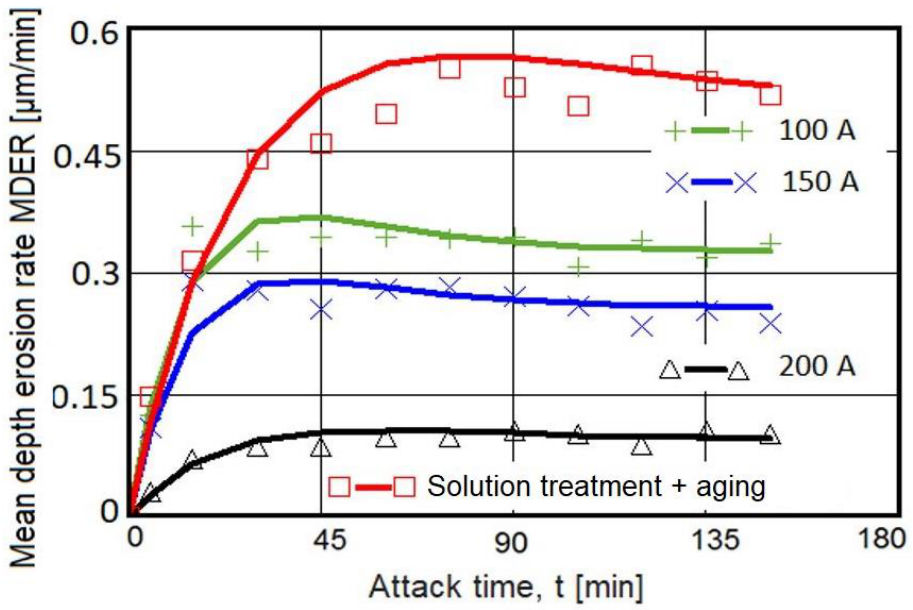
Figure 8. Evolution of the mean erosion rate with the cavitation attack time.